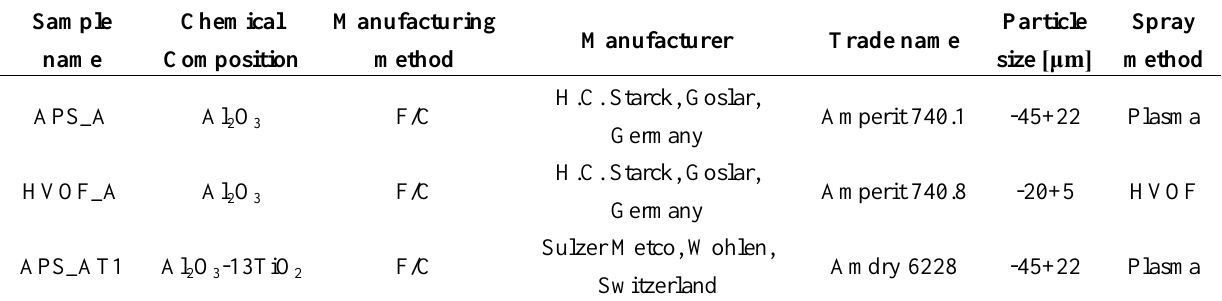
Table 3. Information of the used powders and sample names, F/C stands for fused and crushed, and A/S for agglomerated and